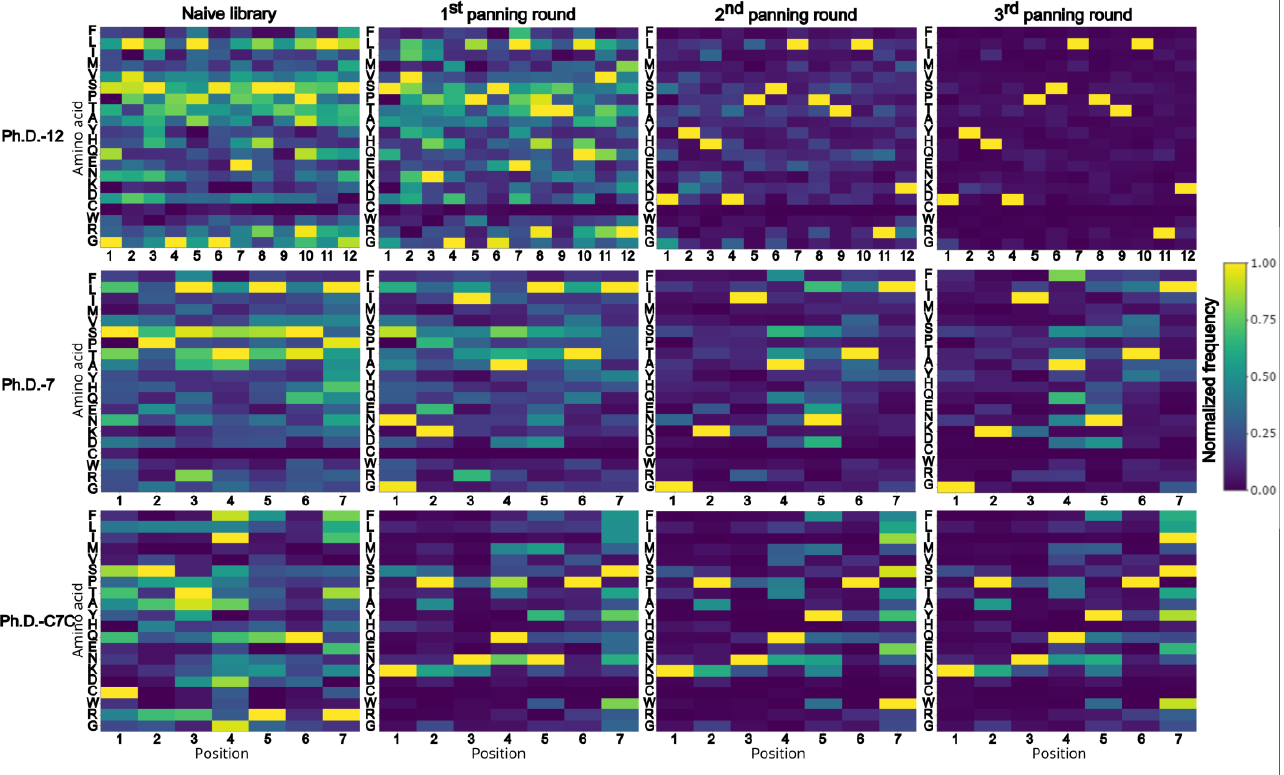
Figure 3. Heatmaps of normalized data from amino acid frequencies of all sequences. Amino acid distribution of normalized data shows positional enrichment of amino acids. Clear shift towards reduced diversity can be seen with successive rounds of panning. Ph.D.-12 is highly affected by the dominant sequence that appears in two-thirds of all sequenced peptides, thus, the overall diversity drops significantly. On the x-axis positions of amino acids are plotted and on the y-axis the respective amino acids are listed in the following order (top to bottom): F, L, T, M, V, S, P, T, A, Y, H, Q, E, N, K, D, C, W, R,